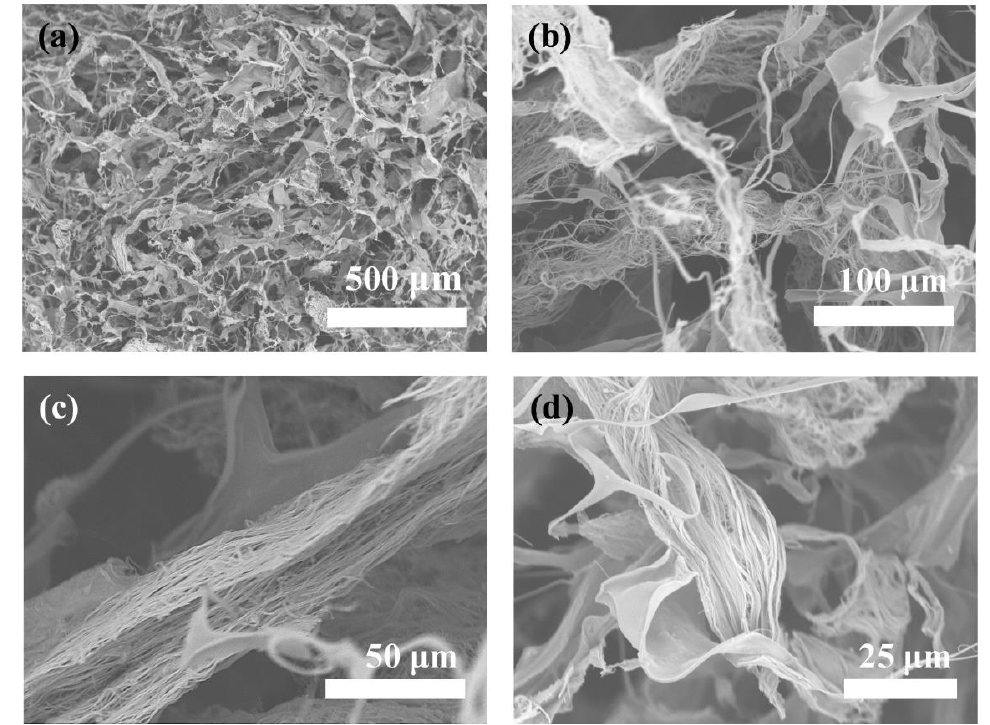
Figure 10. ( a – d ) SEM images of the ultralong HAP nanowire/CS porous scaffold.